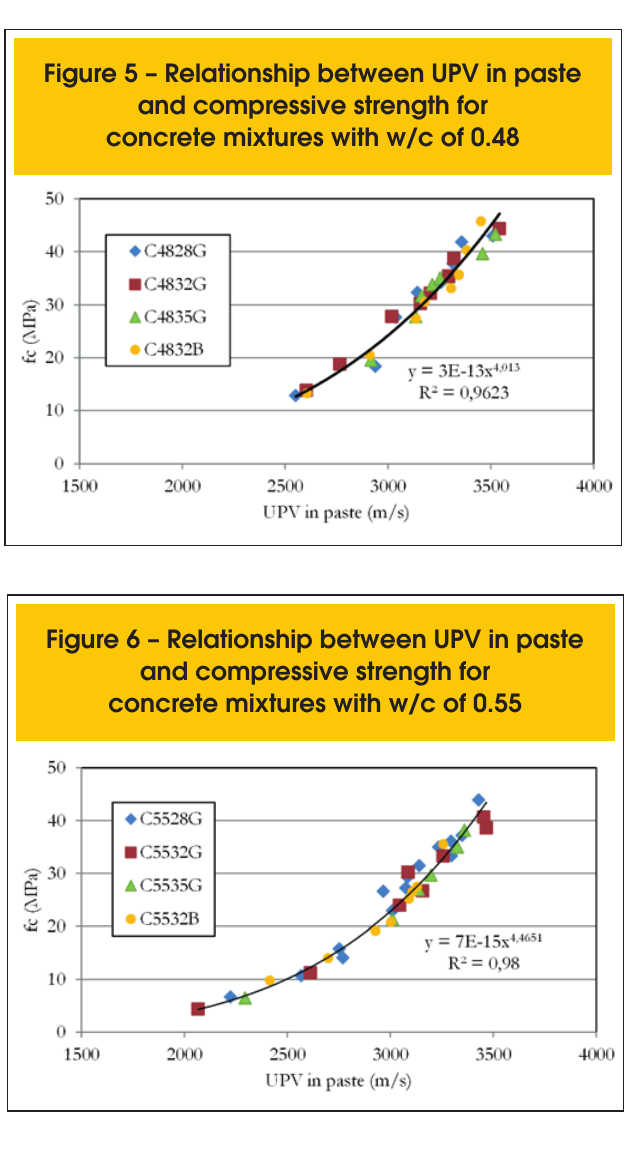
Figure 5 – Relationship between UPV in paste and compressive strength for concrete mixtures with w/c of 0.48